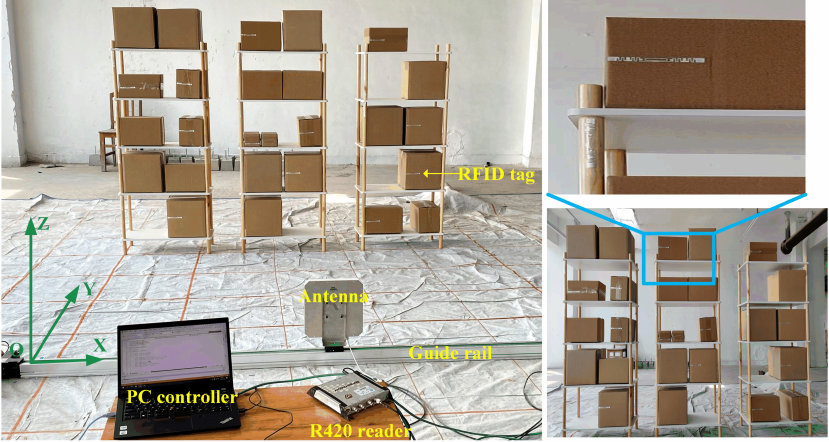
Figure 6. The layout of the RFID localization system.